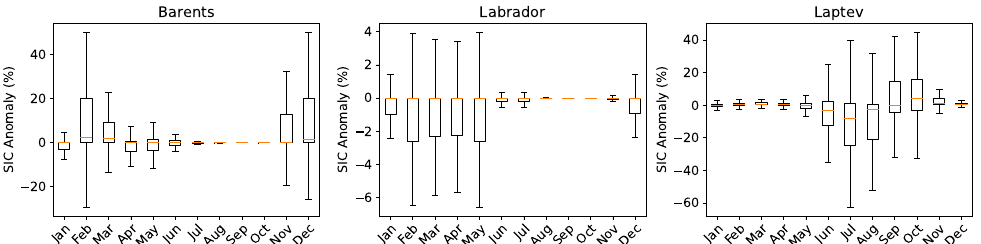
Figure 2. Box and whisker plots of SIC climatological anomaly distribution in JAXA for different months of 2021, aggregated for all the cells in each region. Climatological anomaly is the difference between the data and the climatology of the respective channel (see Section 3.2). The box extends from the 25th percentile to the 75th percentile; whiskers extend the box by 1.5 × of its length. The orange line is the median (50th percentile); outliers are omitted in order not to clutter the